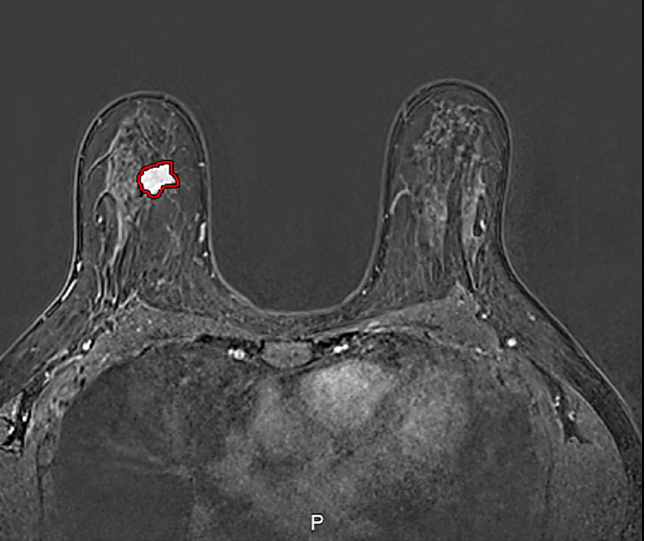
Figure 1. Segmentation (in red) on a single image of the third T1-weighted subtracted series: infil- trating ductal carcinoma in a 39-year-old woman.